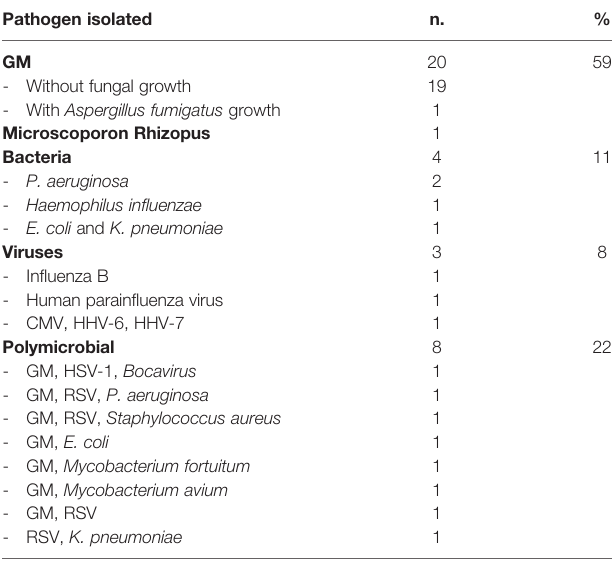
TABLE 2 | Detailed report of pathogens detected by BAL in 36